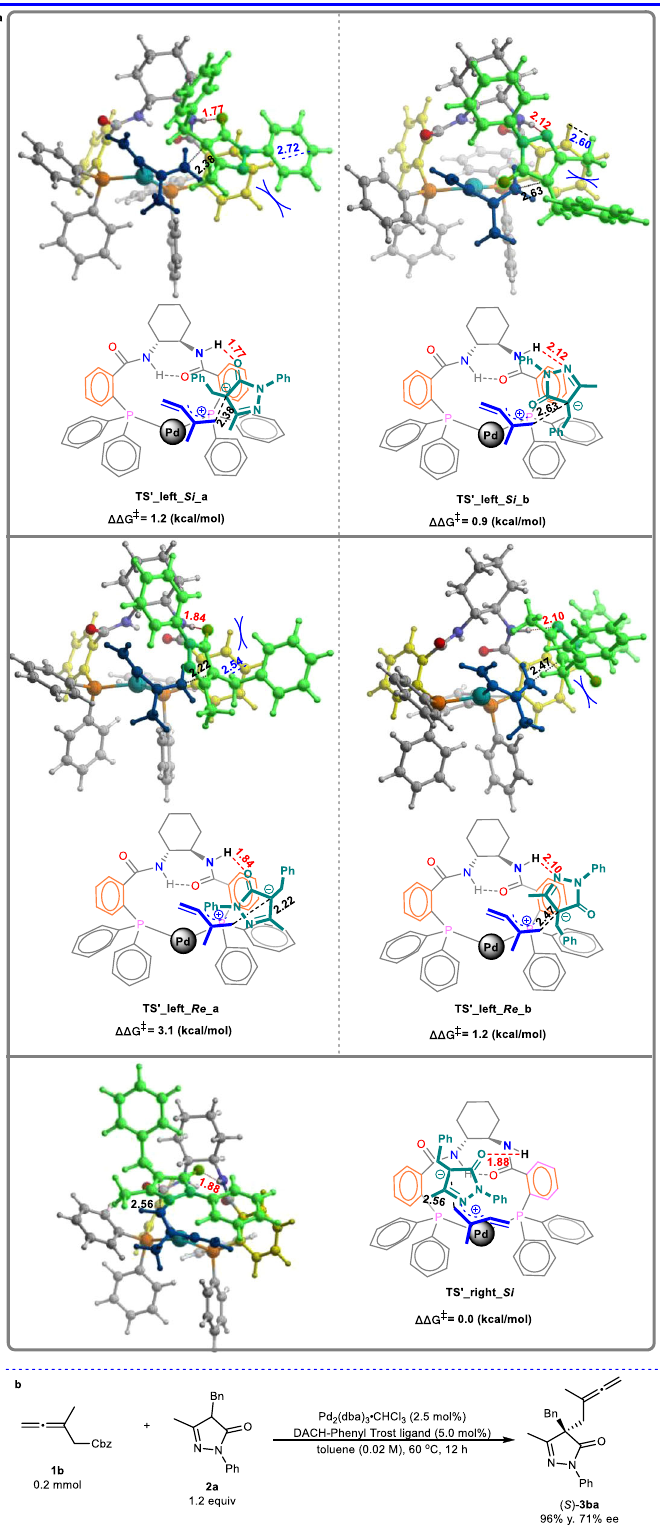
Fig. 7 DFT calculations for the DACH-Phenyl-Trost-ligated palladium catalyst. a DFT-optimized structures and relative energies of ee determining C − C bond formation transition states for the reaction of 1b with 2a catalyzed by the DACH-Phenyl-Trost-ligated palladium catalyst. Hydrogen-bonding interactions are shown as red dash lines; selected bond lengths (Å) are listed. b The reaction of 1b and 2a with DACH-Phenyl-Trost ligand. Cbz benzyloxycarbonyl, DACH (1 R ,2 R )-1,2-diaminocyclohexane, y. NMR